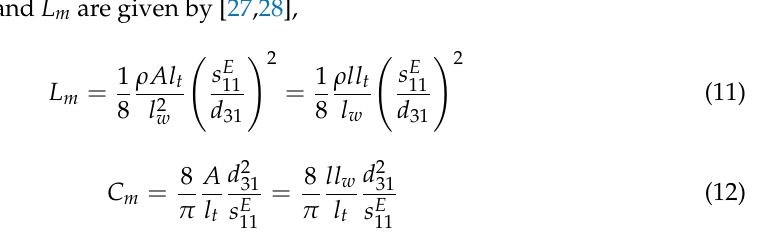
Figure 8. Resonance frequency f s and antiresonance frequency f a of ME resonator as a function of DC magnetic field. The maximum RSDs of f s and f a with multiple measurements are 0.23% and 0.27%, respectively.